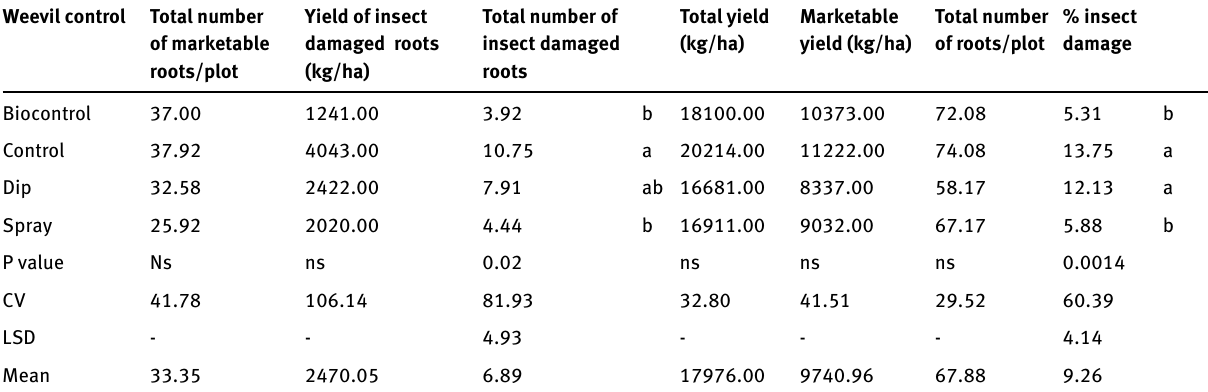
Table 2: Effect of different weevil control treatments on root insect damage in a field trial at Roodeplaat, South Africa during 2015 Weevil control Total